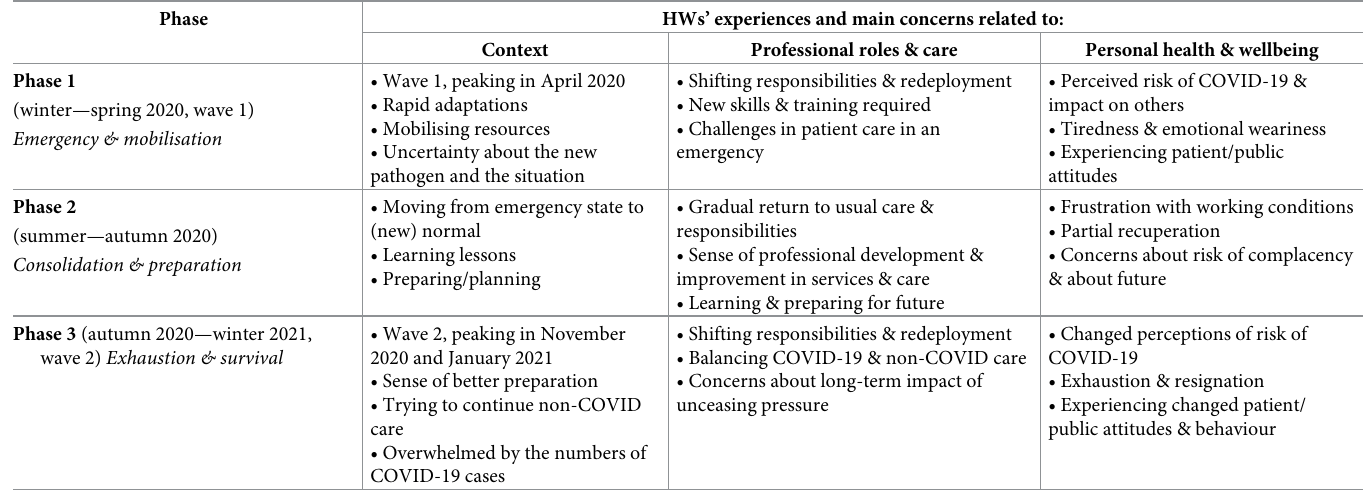
Table 2. Summary of key topics and